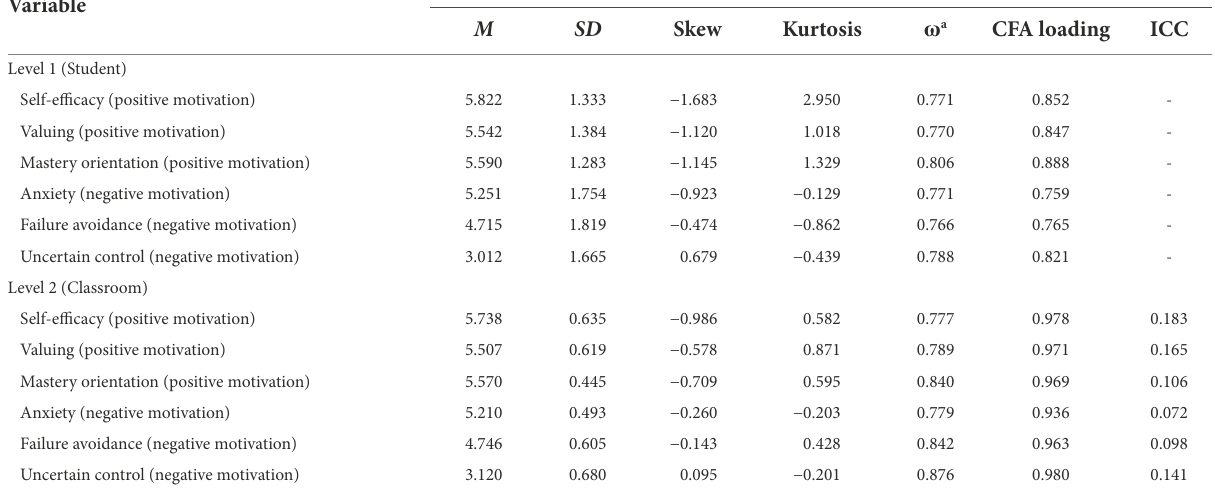
TABLE 1B Multilevel descriptive statistics of motivation items.